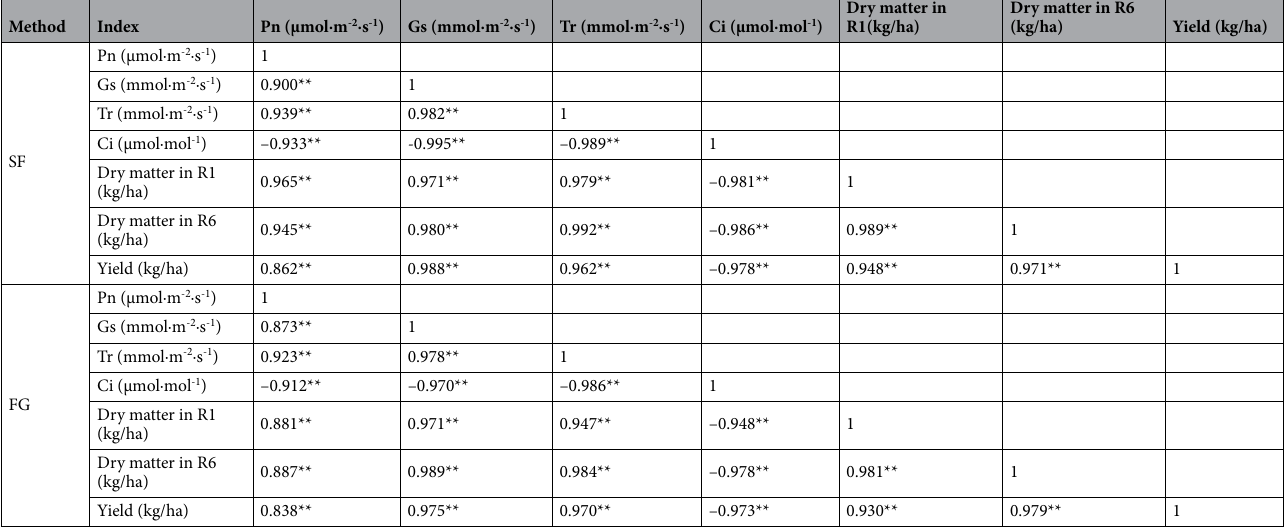
Table 4. Correlation analysis of photosynthesis, dry matter accumulation and yield of maize under two straw return methods.